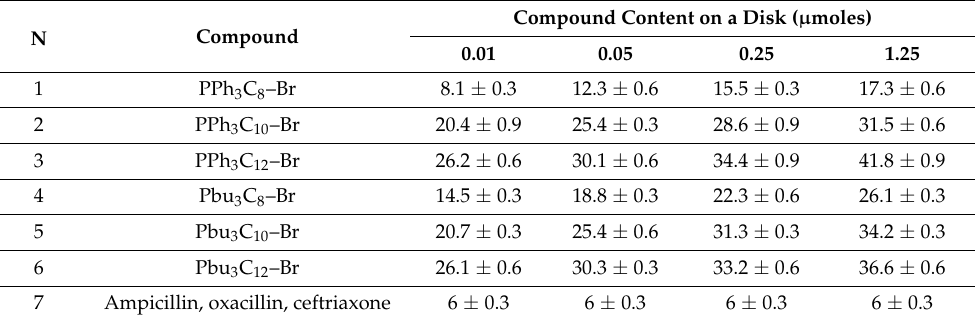
Figure 1. Inhibition zone diameters of the six studied PILs (content on a disk, 1.25 µ moles) of an MDR clinical isolate of A. baumannii on agar plates. Table 3. Inhibition zone diameters (mm) formed by the PILs against A. baumannii ( n =